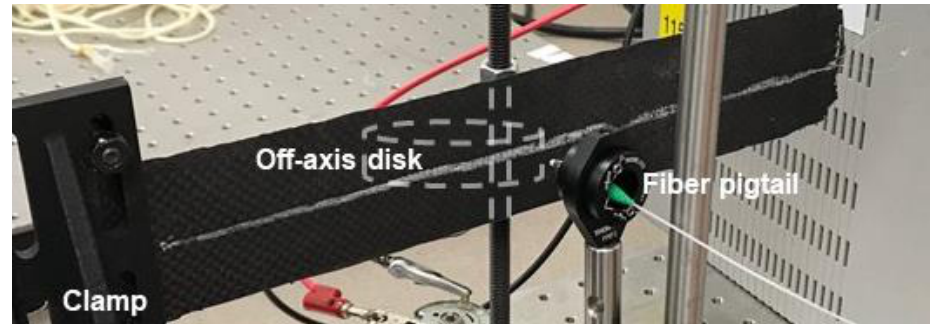
Figure 2. Photo of 6-ply CFRP composite with embedded DOFS. The beam is clamped on the left side in the figure; the off-axis disc to apply strain is hidden behind the specimen (mounted on a vertical rod); the optical fiber pigtail from the laser diode is in front of the specimen.